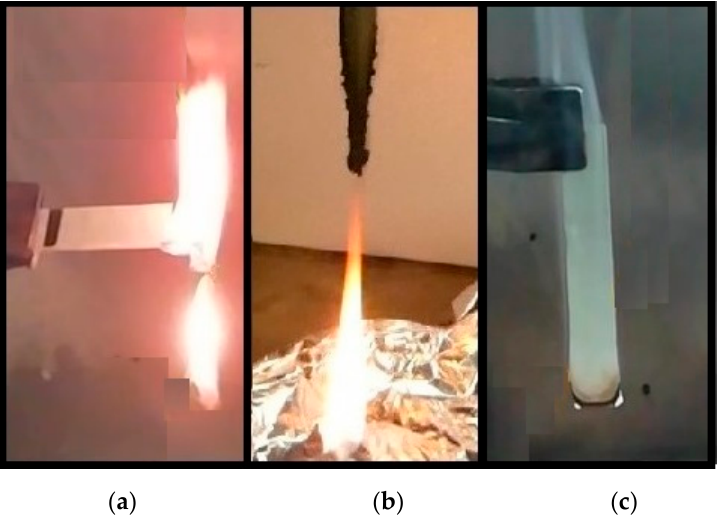
Figure 4. ( a ) PEAL as such in the horizontal test; ( b ) PEALIFR4031 in vertical test; ( c ) PEAL60MH in vertical test.